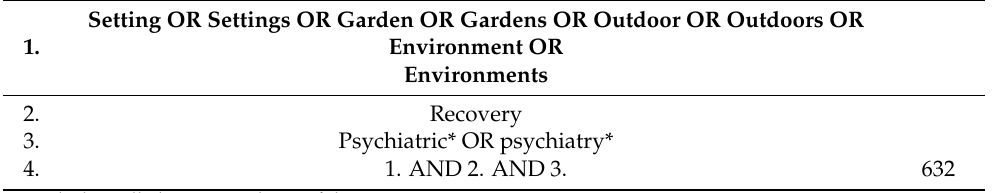
Table A4. Scopus Search Word